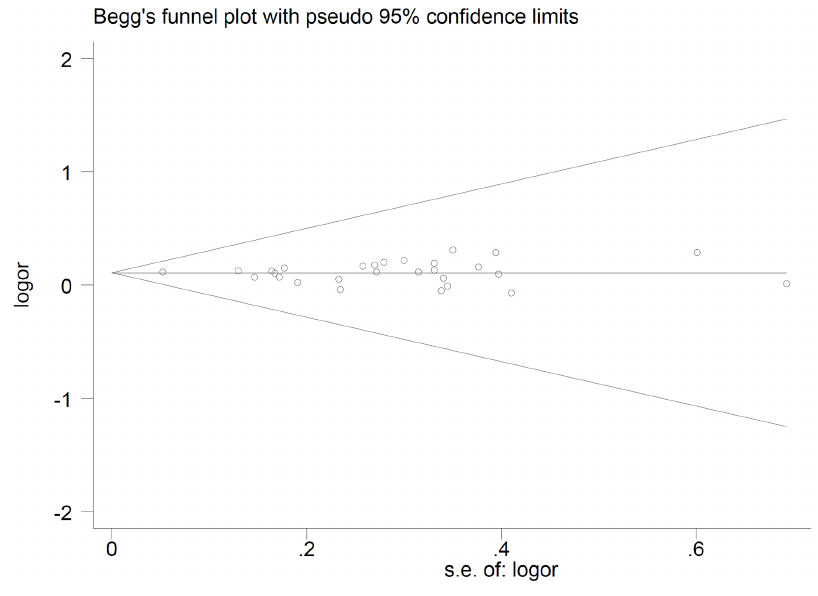
Figure 5. Begg’s funnel plot of MAP3K1 rs889312 polymorphism and breast cancer risk.